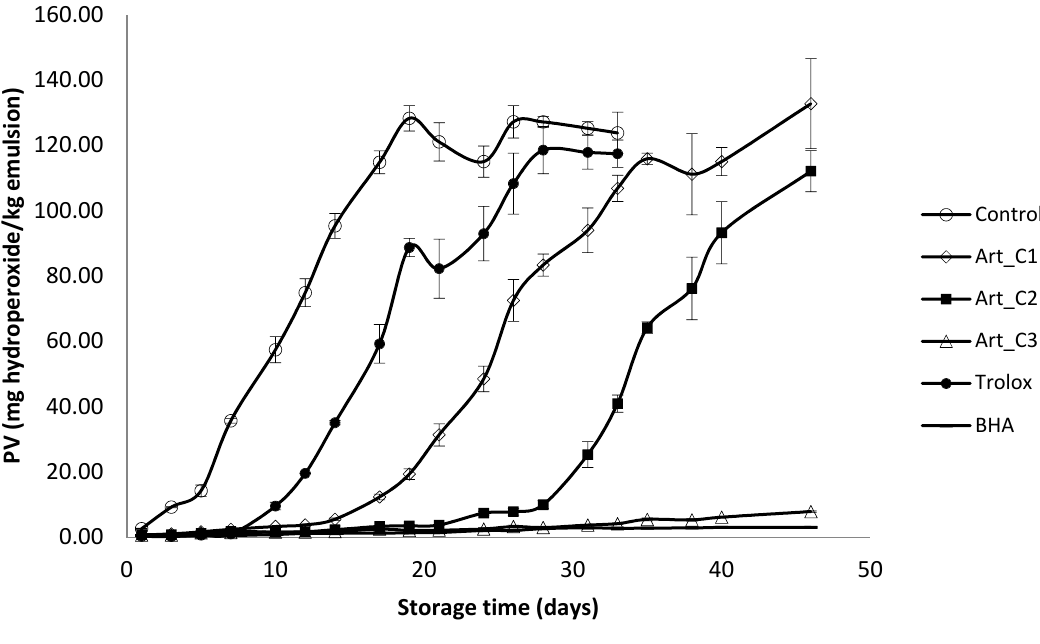
Figure 1. Evaluation of primary oxidation (peroxide value) in a model food system (O/W emulsion 10% of oil) with different concentrations of A. annua (C1: 0.20 g/L; C2: 0.65 g/L and C3: 2